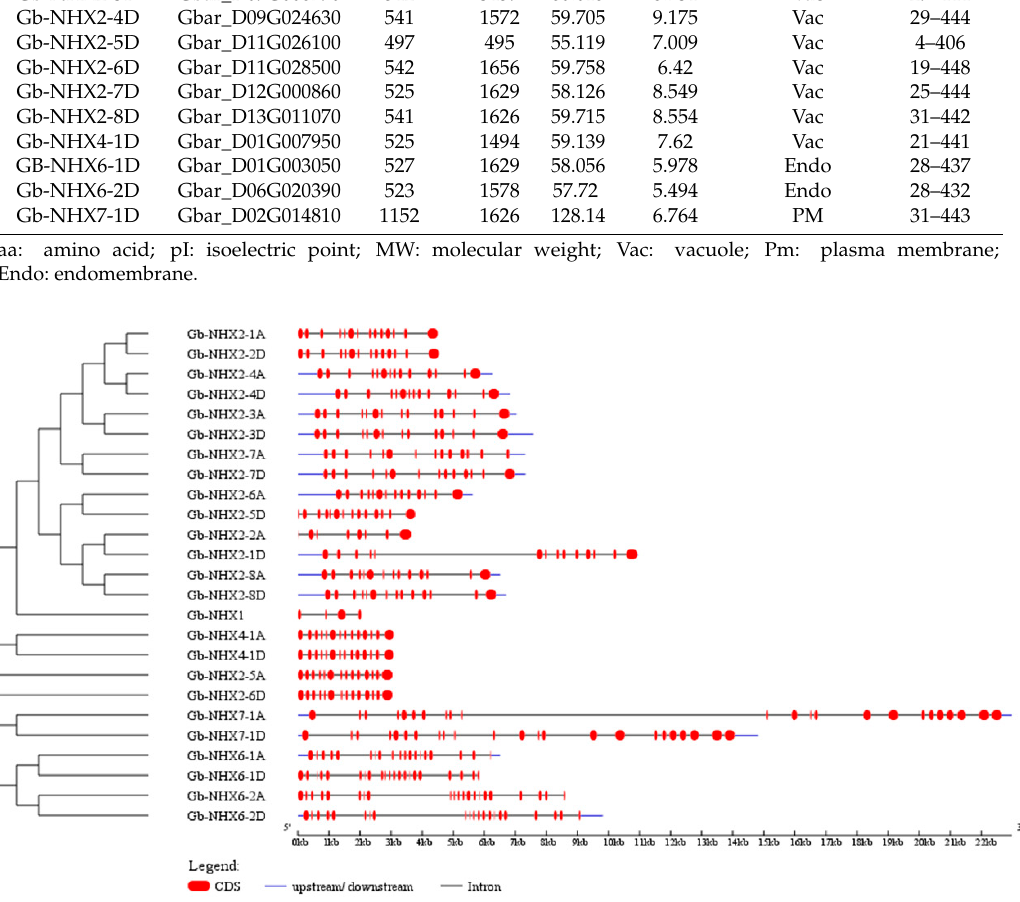
Figure 1. Gene Structure of the G. barbadense NHX transporters. Red box represents the exons and the black lines represent the introns.